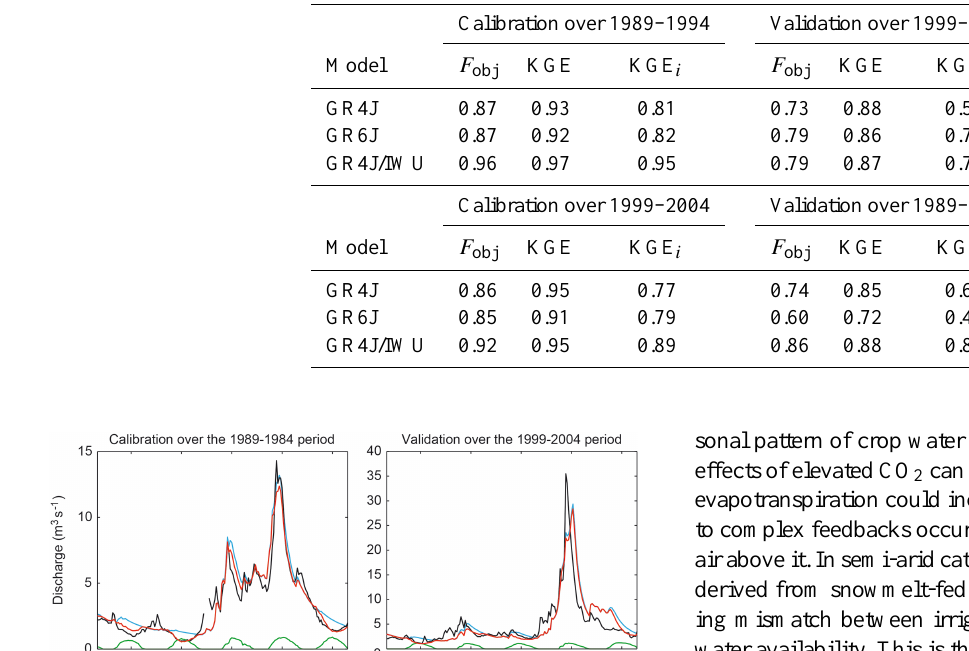
Table 2. Goodness-of-fit (calibration) and predicting performance (validation) of the hydrological models.